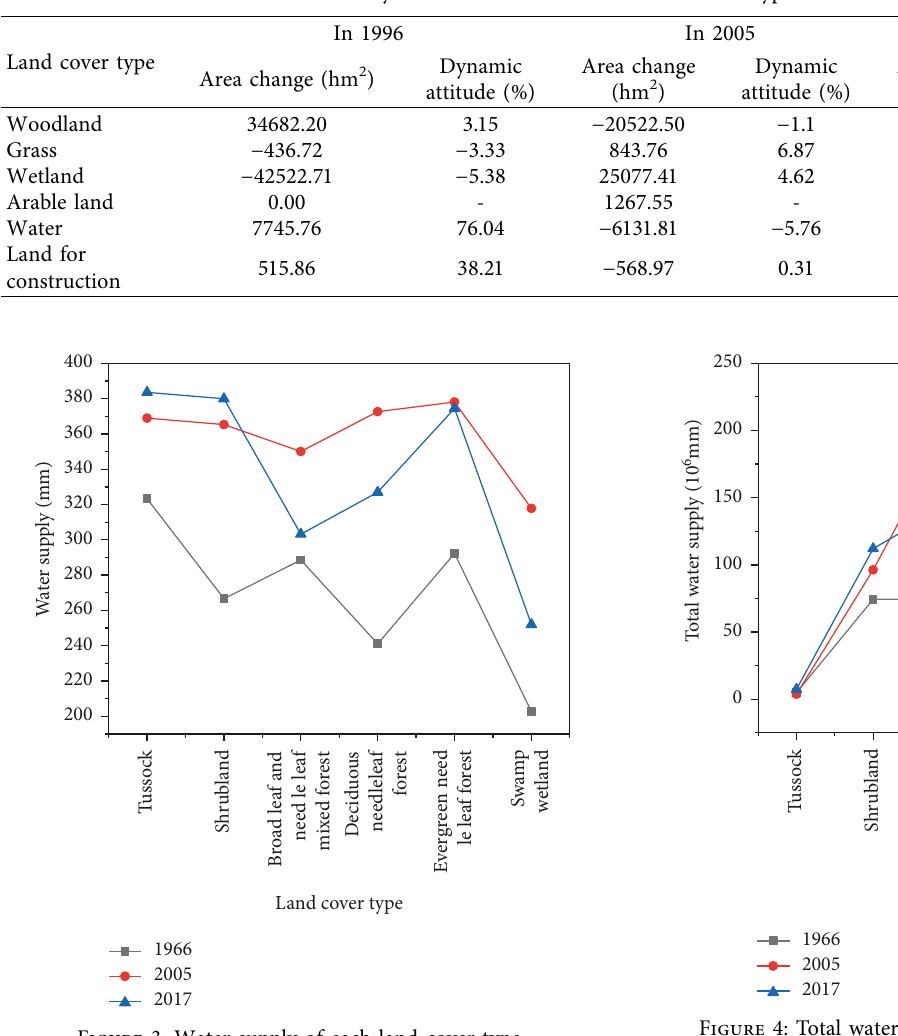
Table 7: Dynamic attitudes of different land cover types in the study area.